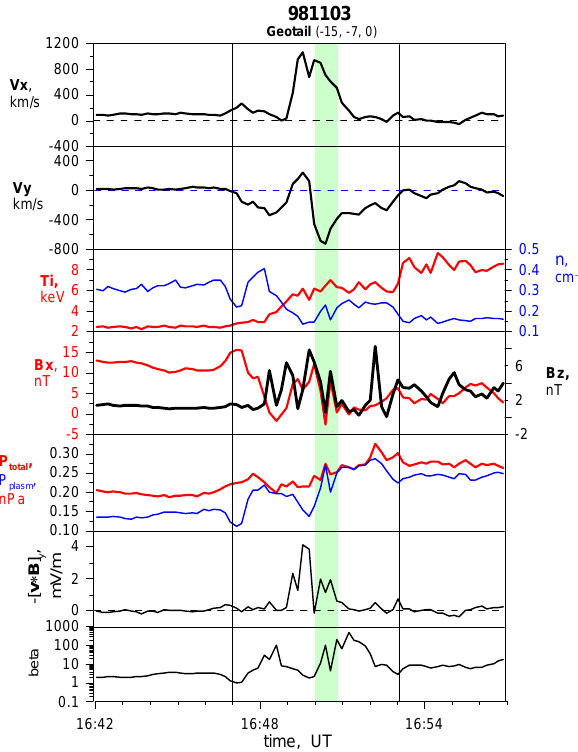
Figure 4 Variation of the plasma parameters and magnetic field Fig. 4. Variation of the plasma parameters and magnetic field com- components observed on 4 Sept. 1997. The time interval with |Vy|>400 is highlighted. ponents observed on 4 September 1997. The time interval with | Vy | > 400 is